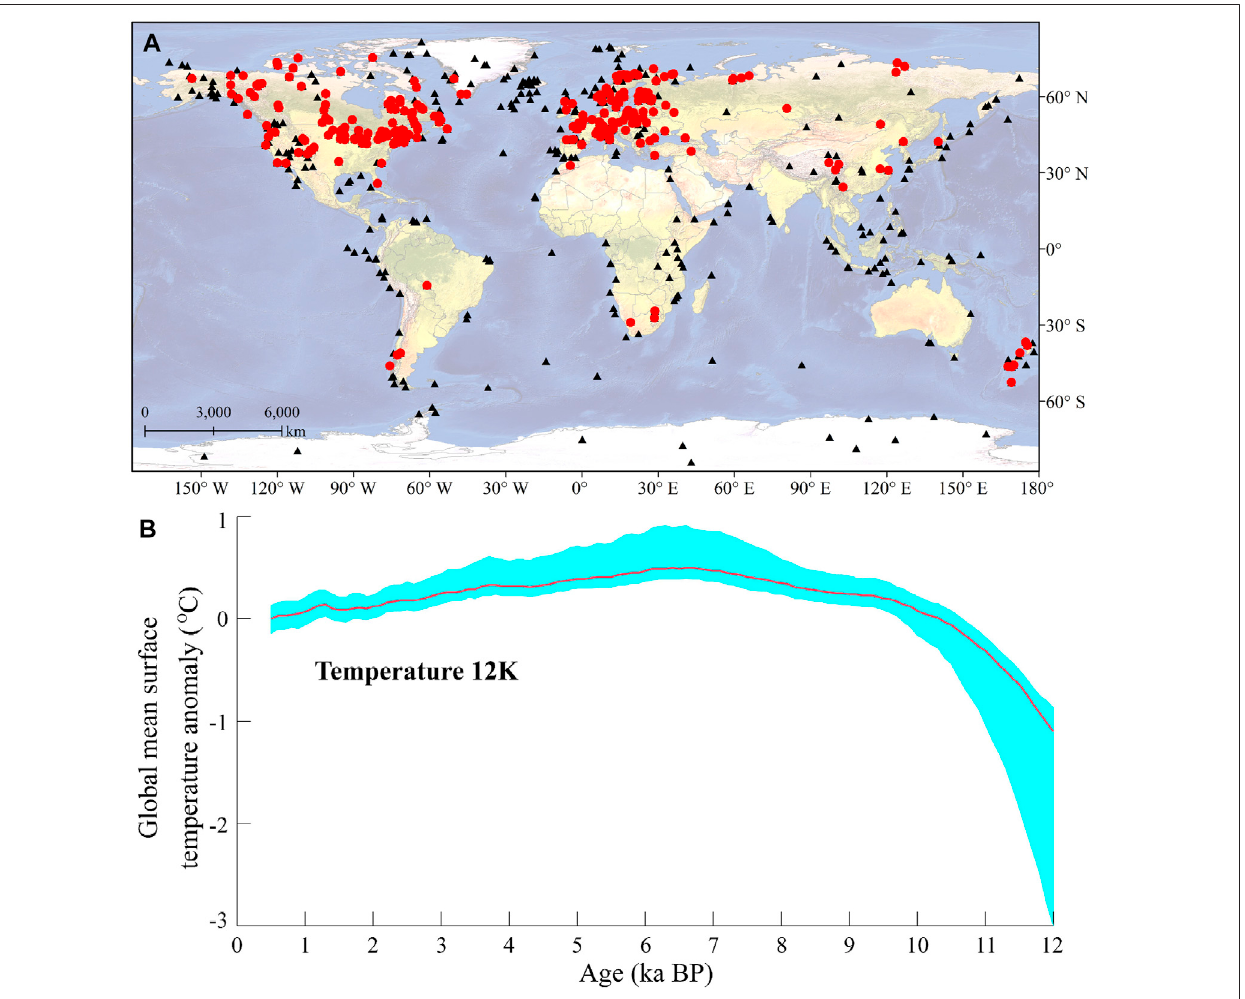
FIGURE 3 | Spatial distribution of 1,319 selected global records (A) (note that most of them are pollen records, represented by red dots) and the corresponding stacked global mean surface temperature record (B) ; Kaufman et al., 2020a.